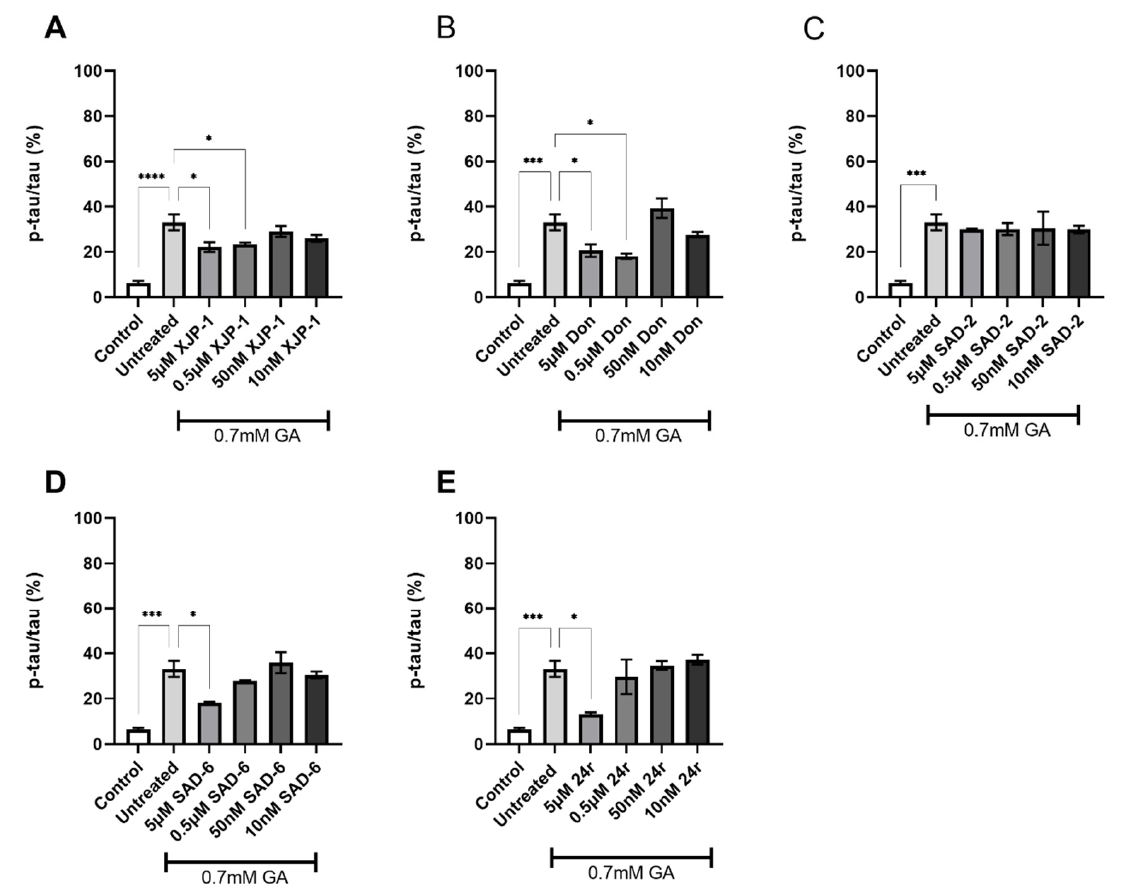
Figure 4. Tau S199 phosphorylation levels in 0.7 mM GA-exposed neurons after treatment with novel AChE inhibitors. ( A ) Quantification of phosphorylation ratio pTau/tTau on S199 of 0.7 mM GA-treated SH-SY5Y-differentiated neurons after XJP-1 treatment. ( B ) Quantification of phosphor- ylation ratio pTau/tTau on S199 of 0.7 mM GA-treated SH-SY5Y-differentiated neurons after Donepezil treatment. ( C ) Quantification of phosphorylation ratio pTau/tTau on S199 of 0.7 mM GA- treated SH-SY5Y-differentiated neurons after SAD-2 treatment. ( D ) Quantification of phosphoryla- tion ratio pTau/tTau on S199 of 0.7 mM GA-treated SH-SY5Y-differentiated neurons after SAD-6 treatment. ( E ) Quantification of phosphorylation ratio pTau/tTau on S199 of 0.7 mM GA-treated SH- SY5Y-differentiated neurons after 24r treatment. Kruskal–Wallis test followed by Dunn’s post-hoc was used to compare the differences between different groups. Data are expressed as mean ± SEM, n = 3 with at least 5 repetitions per experiment,* p < 0.05; *** p < 0.001, **** p < 0.0001.